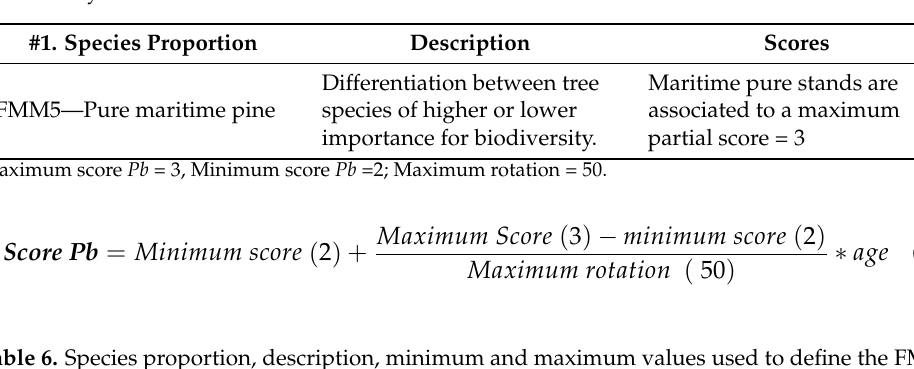
Table 5. Species proportion, description, minimum and maximum values used to define the FMM5 biodiversity score.